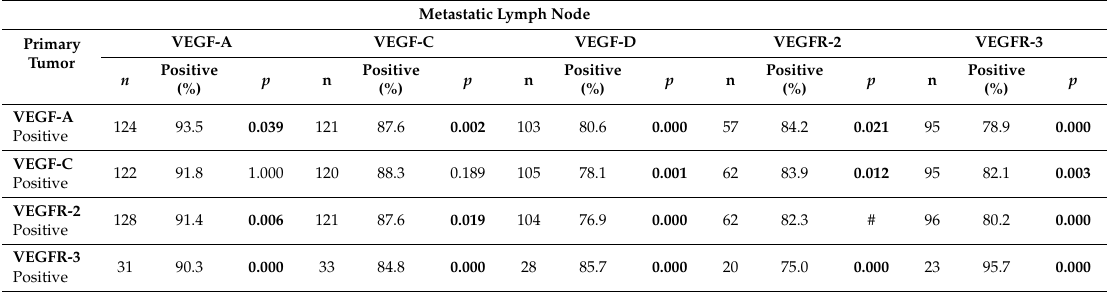
Table 7. Pattern of protein staining in primary tumor versus the respective metastatic lymph nodes in CRC. In bold the significant